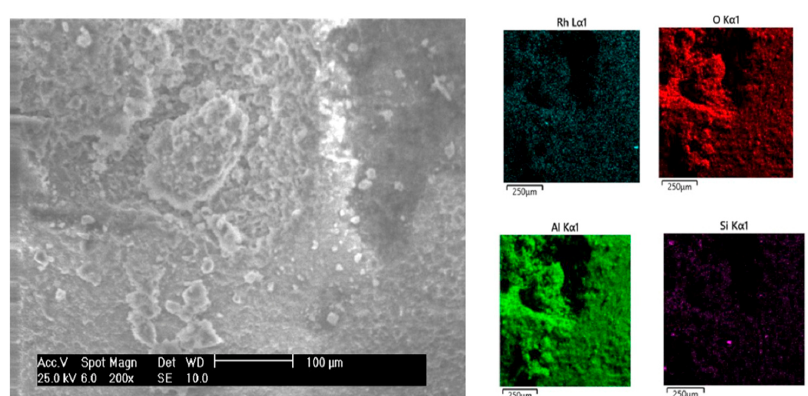
Figure 3. SEM-EDX Ru- γ Al 2 O 3 .